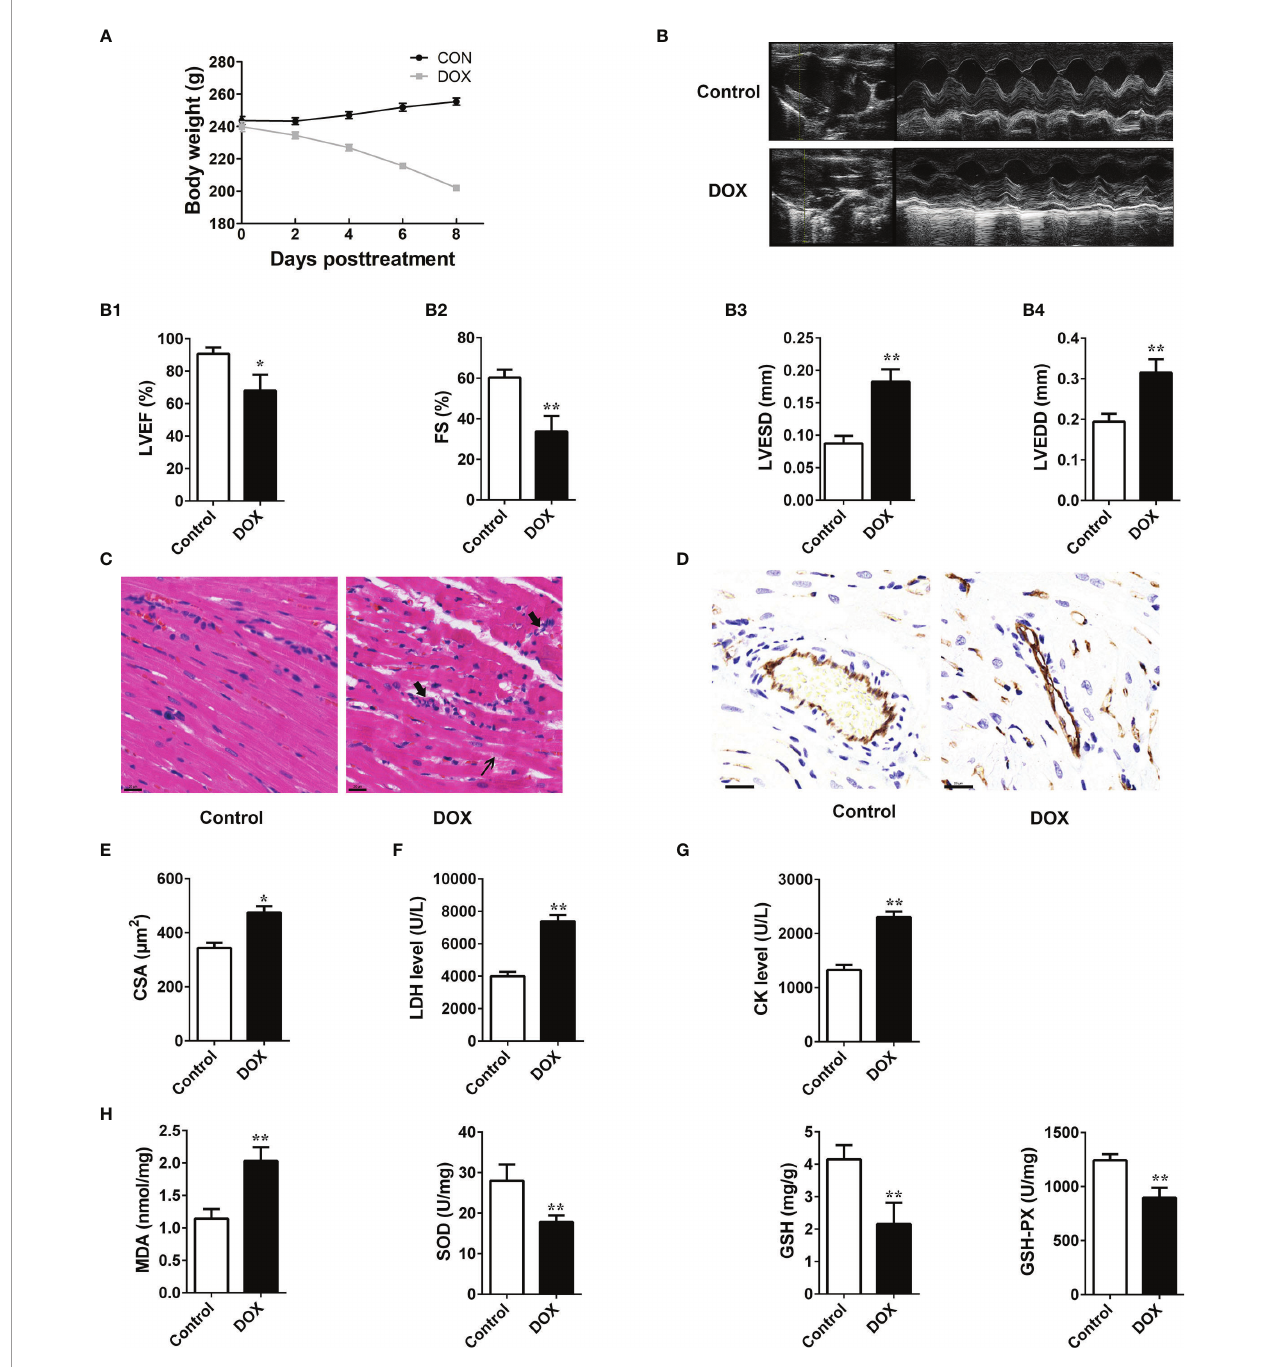
FIGURE 1 | The impacts of DOX on the rat heart. (A) Daily body weight changes. (B) Representation of M-mode left ventricular (LV) echocardiogram. (B1) Left ventricular ejection fraction (LVEF), (B2) FS: fractional shortening, (B3) left ventricular end-systolic diameter (LVESD) and (B4), left ventricular end-diastolic diameter (LVEDD). (C) Representative images of HE-staining of rat heart tissues treated with or without doxorubicin (DOX) for 8 days. The structure of dysregulated myocytes is marked as thin arrowhead, in fl ammatory cell in fi ltration marked as thick arrowhead. Scale bars: 20 m m (center and right panels). (D) Representative photos of CD31 immunohistochemical staining in each group. Scale bars: 20 m m. (E) Cross-sectional areas (CSA) of cardiomyocytes in the LV. (F, G) Serum levels of LDH and CK in rats. (H) Determination of MDA, SOD, GSH and GSH-Px in the tissues. Data are presented as the mean ± SEM. * p < 0.05 and ** p < 0.01 vs